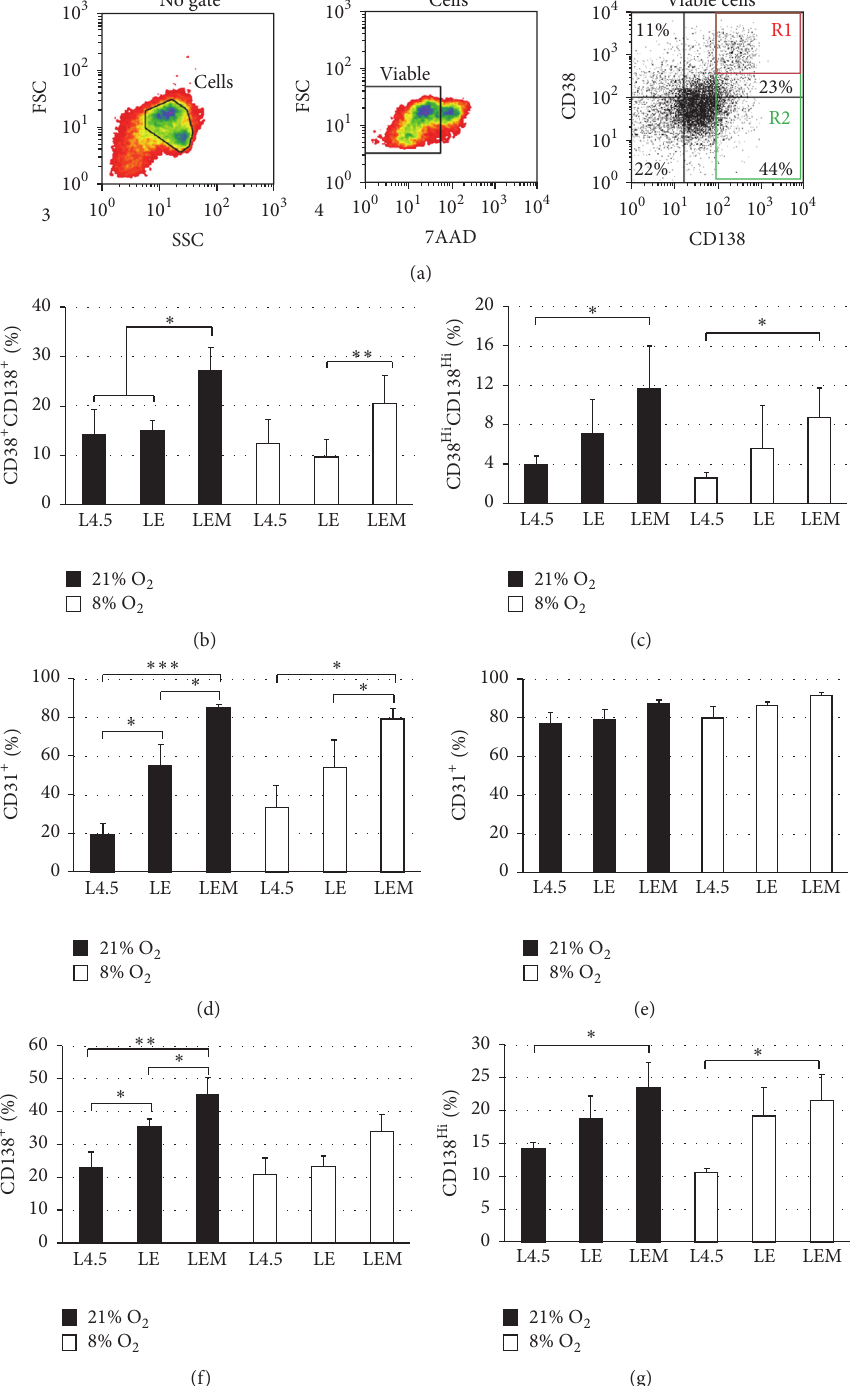
Figure 3: Effects of eosinophil and mesenchymal stem cells on the differentiation of switched memory B lymphocytes. Switched memory B lymphocytes were cultured as described in Figure 2(a) for the expansion and transition phases. Then, cells were exposed to L4.5 cells (L) alone or in combination with EOL-1 cells (E) or EOL-1 cells plus bone marrow MSC (M) during the differentiation phase. During that phase, all cultures were done in 21% and 8% O 2 condition. (a) Plasma cell content was determined on day 20 by excluding debris and dead cells. Analysis relative to CD38 + CD138 + cells is gated within the upper right (UR) quadrant, and results are shown in (b) and (d). Results for CD38 hi CD138 hi population, gated within R1 (red square), were analysed in (c) and (e). (g) Analysis for CD138 hi cells gated within R2 (green square). (b) Frequencies of CD38 + CD138 + , (c) CD38 hi CD138 hi , (d-e) CD31 + , (f) CD138 + , and (g) CD138 hi populations are shown for 7 independent experiments for cells cultured in the presence of L4.5 cells alone and for 5 independent experiments for LE and LEM assays. Statistical analyses were done using a Dunn multiple comparison 𝑡 -test with 𝑝 values as indicated: ∗ 𝑝 ≤ 0.05 , ∗∗ 𝑝 ≤ 0.01 , and ∗∗∗ 𝑝 ≤ 0.005 . Data are presented as means ±